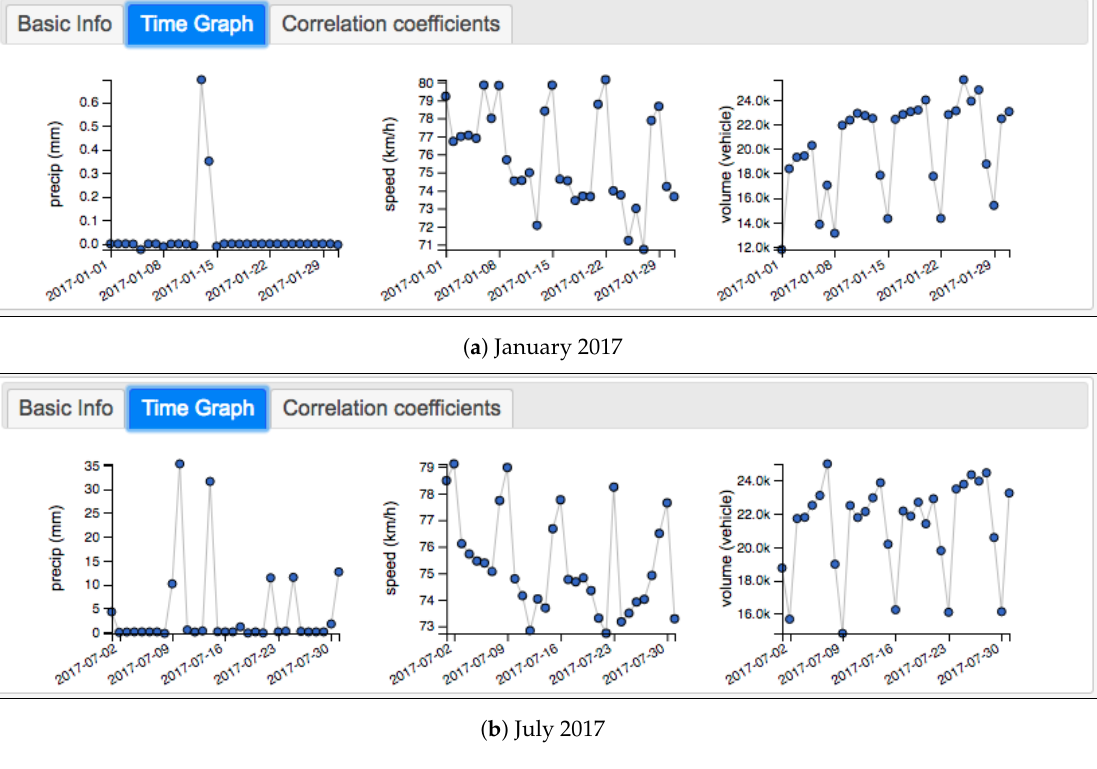
Figure 10. Diagrams of time series at TS3 for precipitation, traffic speed, and